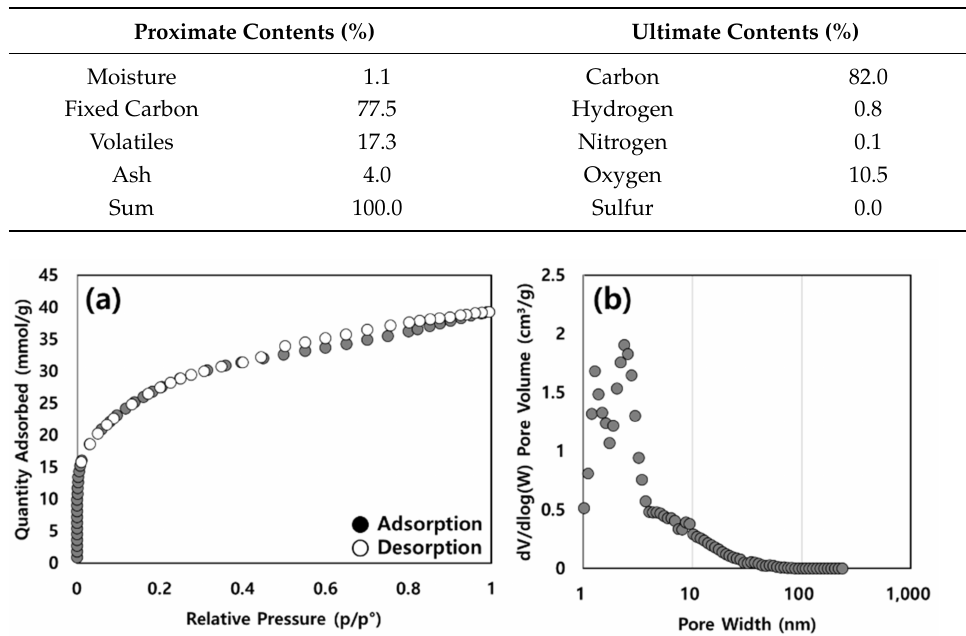
Figure 1. ( a ) Nitrogen adsorption–desorption isotherms and ( b ) pore size distribution of activated carbon.